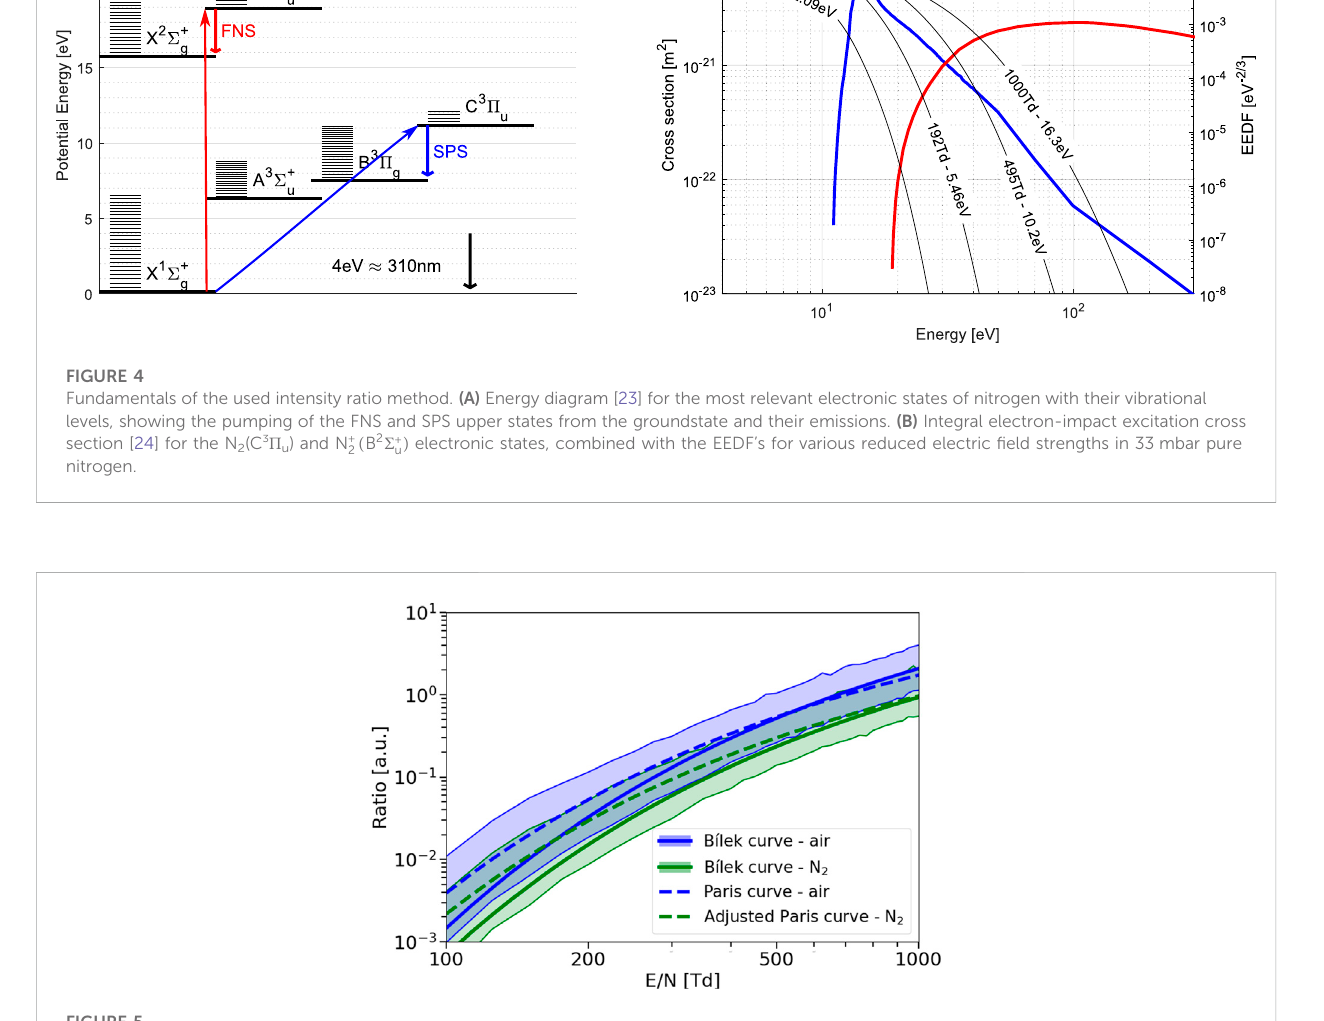
FIGURE 5 The calibration curves, relating the ratio of FNS(0 – 0) and SPS(2 – 5) emissions to reduced electric fi eld strengths, for Paris [26] divided by a factor of 2 and Bílek [13, 25] for synthetic air and nitrogen at 33